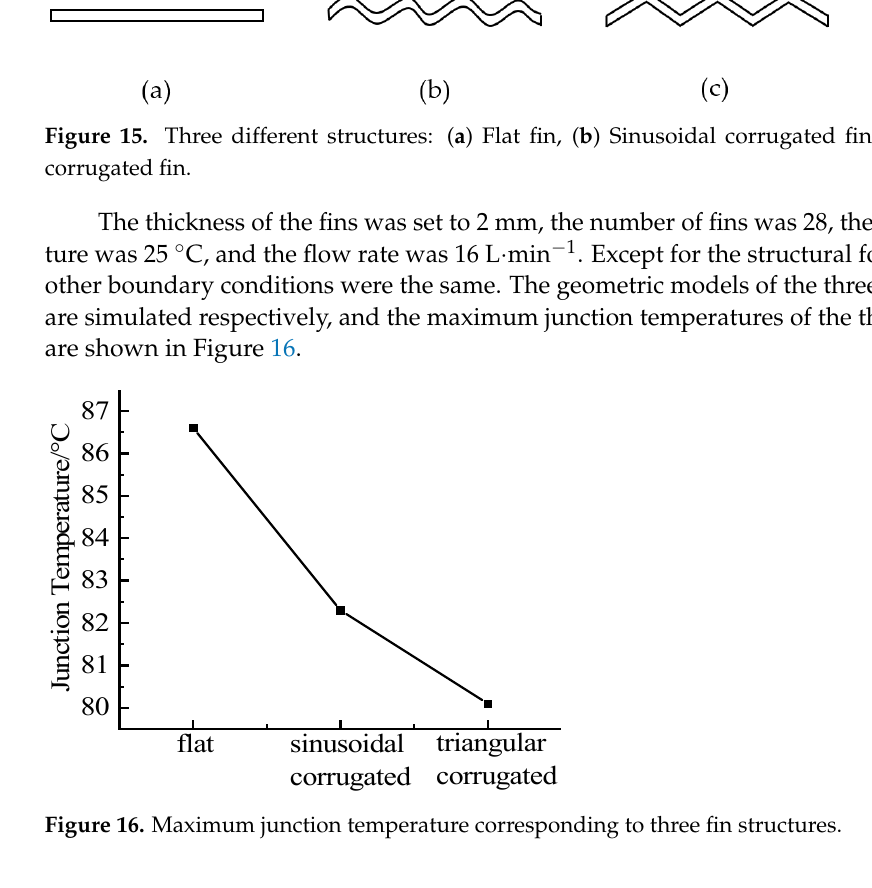
are shown in Figure 15.